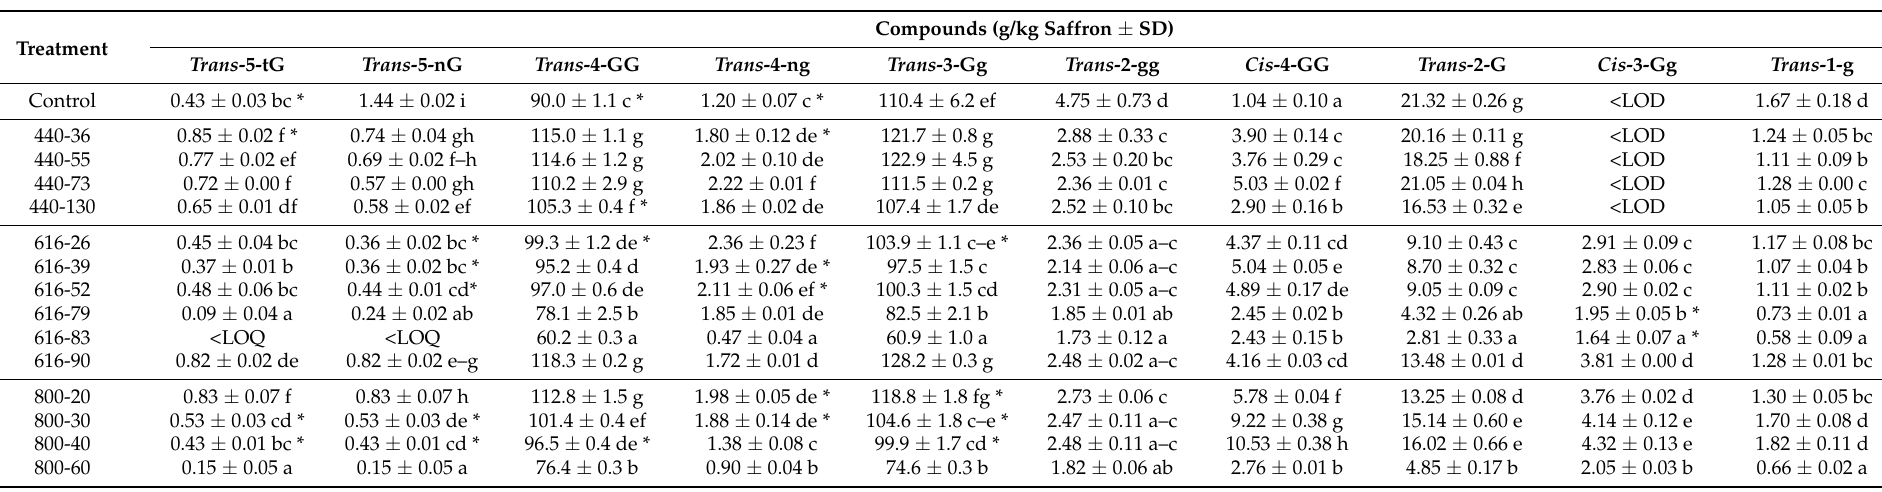
Table 5. Crocetin esters content of saffron obtained under different dehydration treatments after being stored for three